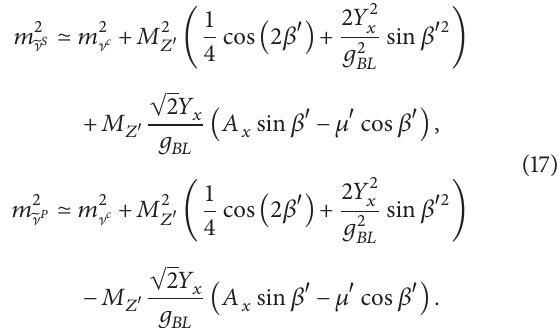
= 125 GeV are shown in 1